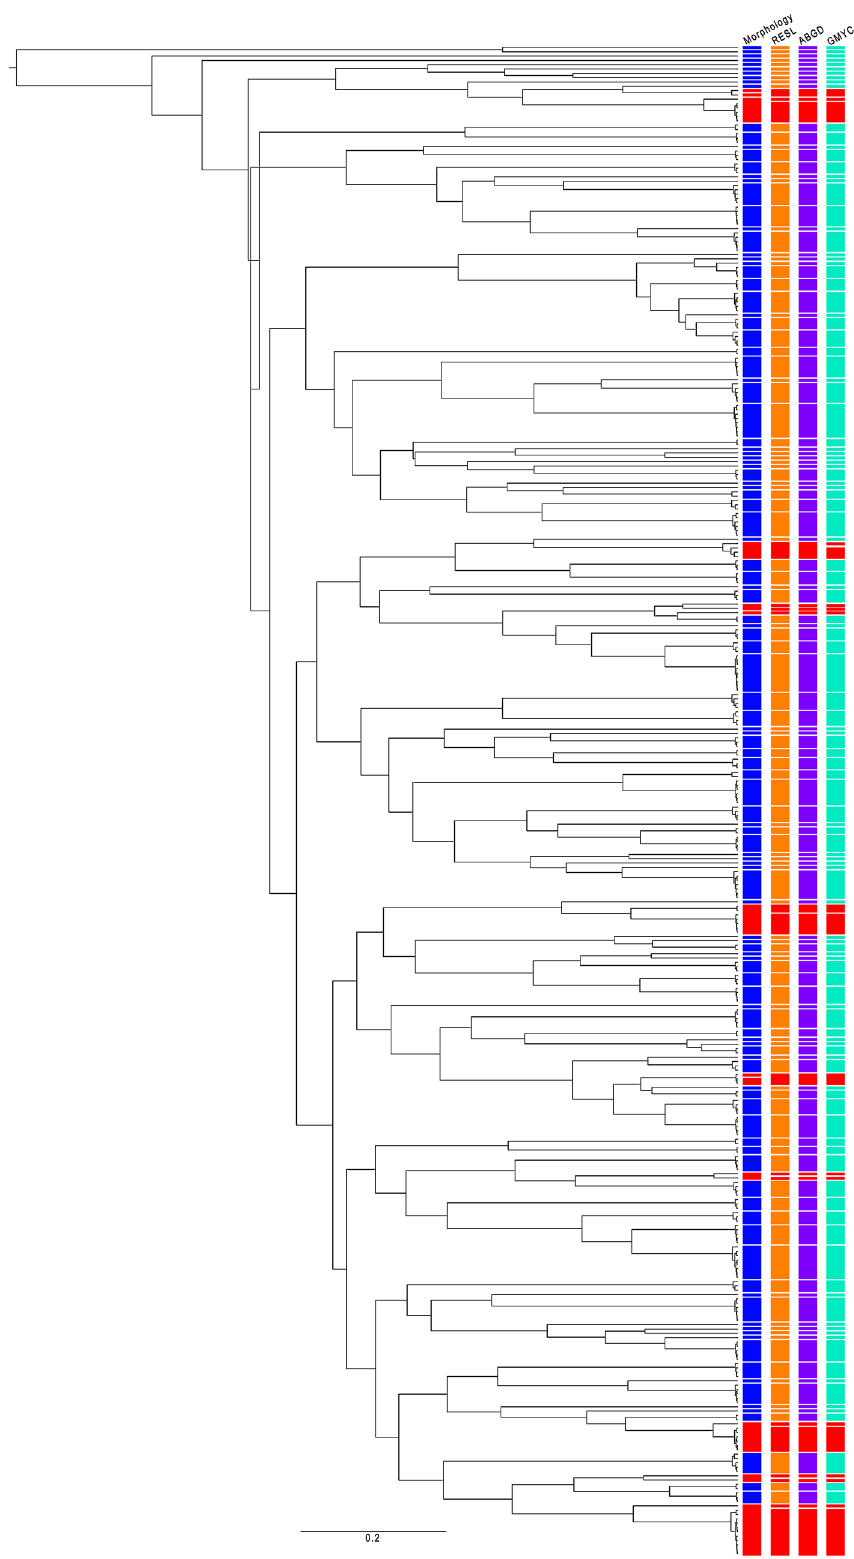
Figure 4. Bayesian Inference gene tree based on the 350 DNA barcodes with delineated MOTUs. Colour bars indicate (from left to right): morphological species (blue), MOTUs delineated by RESL (orange), ABGD (purple), and GMYC (green). Red bars indicate discrepancies among the different schemes (either morphology- genetics discrepancies or genetics-genetics